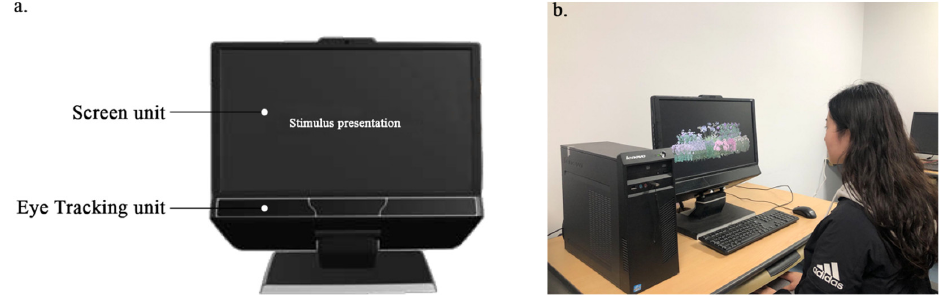
Figure 4. Eye-tracking equipment used for this study: ( a ) the Tobii TX300 Eye Tracker and ( b ) a participant